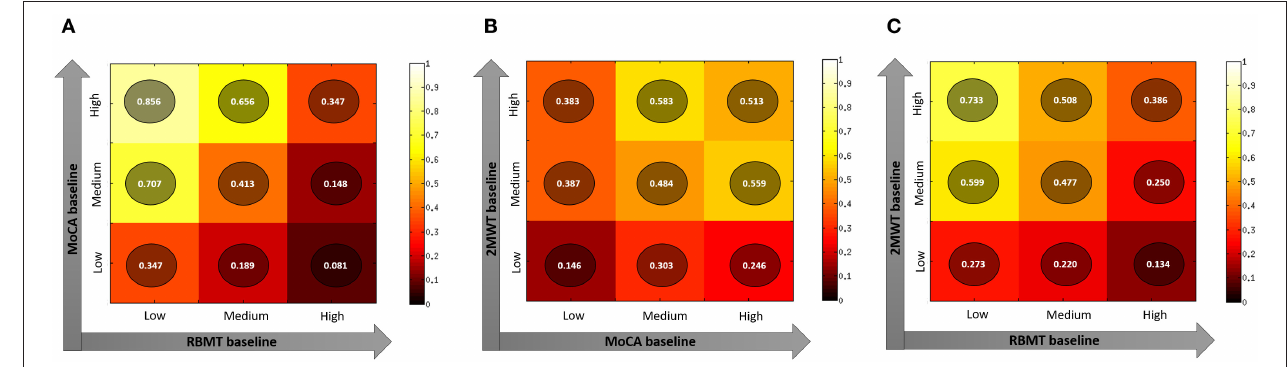
FIGURE 1 | Plots representing predicted probability of different combination of best predictors (Panel A : MoCa and RBMT; Panel B : 2MWT and MoCA; Panel C : 2MWT and RBMT) of the RBMT-3–GMI change after rehabilitation. Panel (A) MoCA value at baseline and RBMT value at baseline; Panel (B) 2MWT value at baseline and MoCA value at baseline; Panel (C) 2MWT value at baseline and RBMT value at baseline. 2MWT, 2-Minute Walk Test; MoCA, Montreal Cognitive Assessment; RBMT-3–GMI, Rivermead Behavioral Memory Test-3–Global Memory